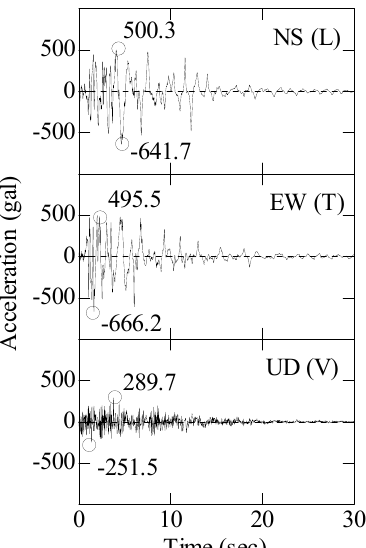
Figure 7. Recording of 1995 Kobe earthquake by Japan Railway Takatori Station of (JRT).